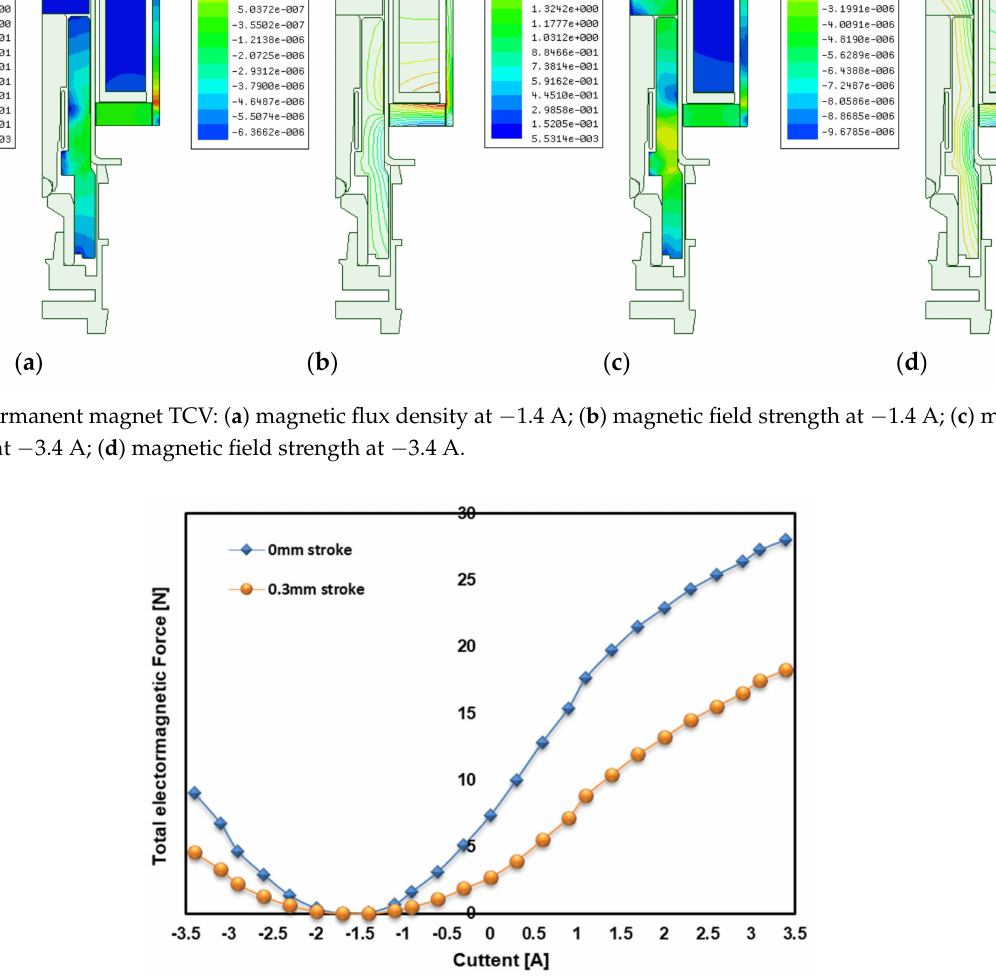
Figure 16. Total electromagnetic force for each stroke in the permanent magnet